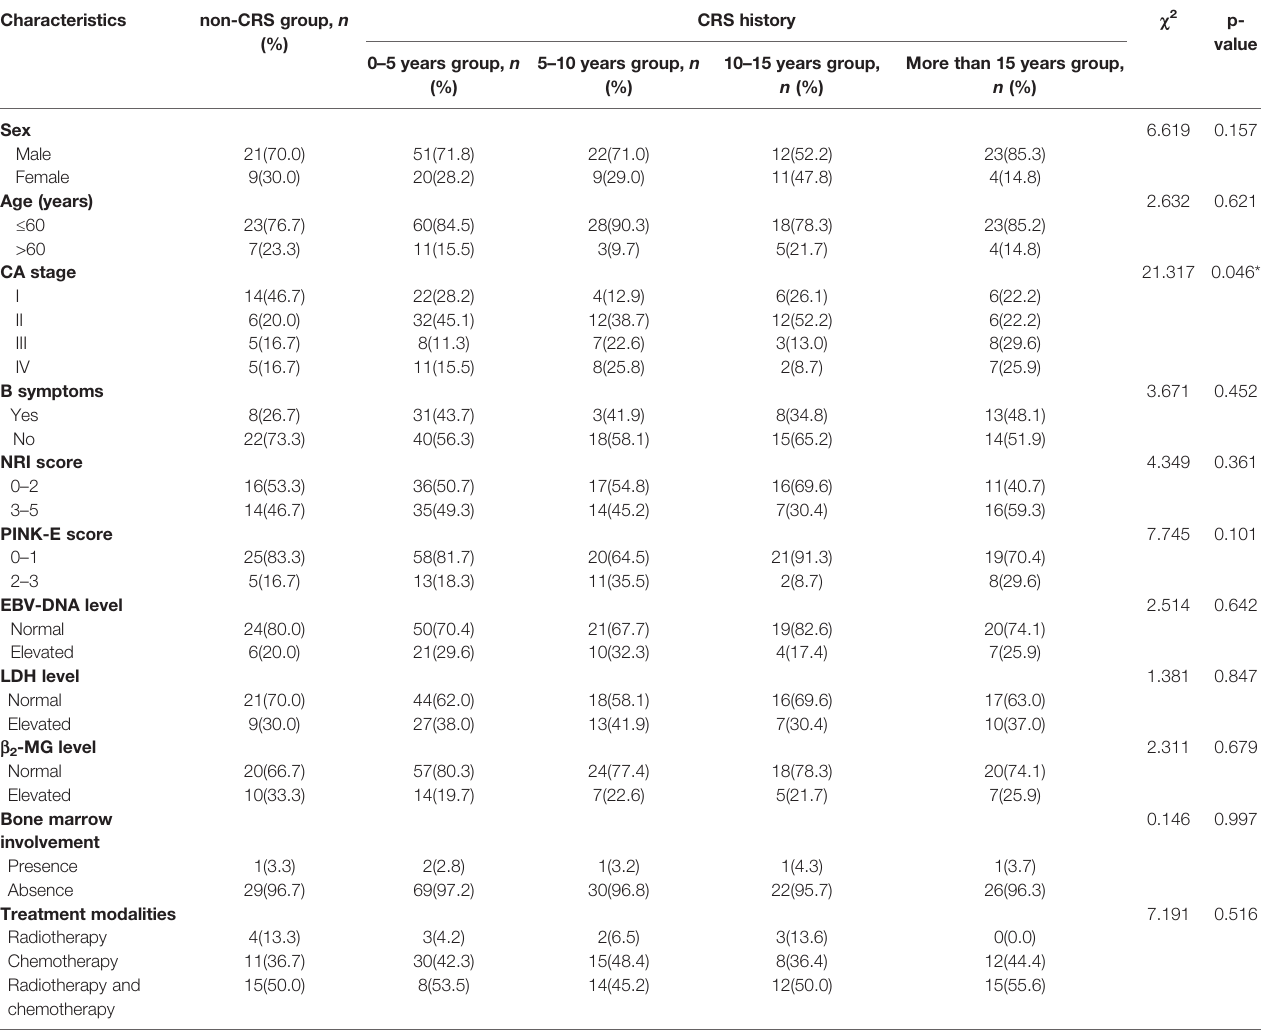
TABLE 3 | Comparison of clinical characteristics of 182 UAT-ENKTL patients with non-CRS group, CRS history of 0 – 5 years group, 5 – 10 years group, 10 – 15 years group, and more than 15 years group.